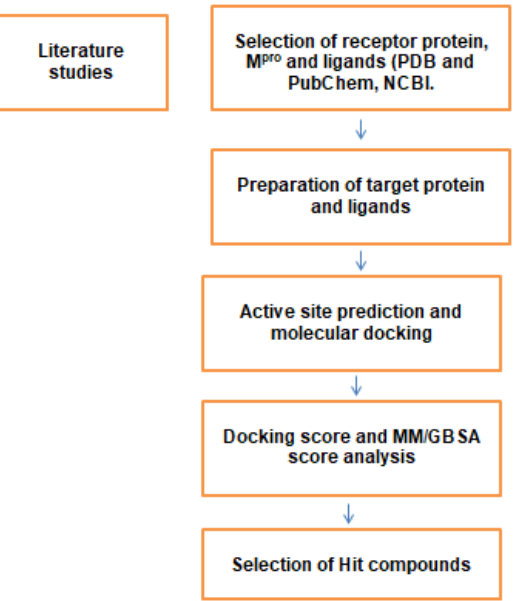
Figure 1. Schematic representation of the workflow used in this study.